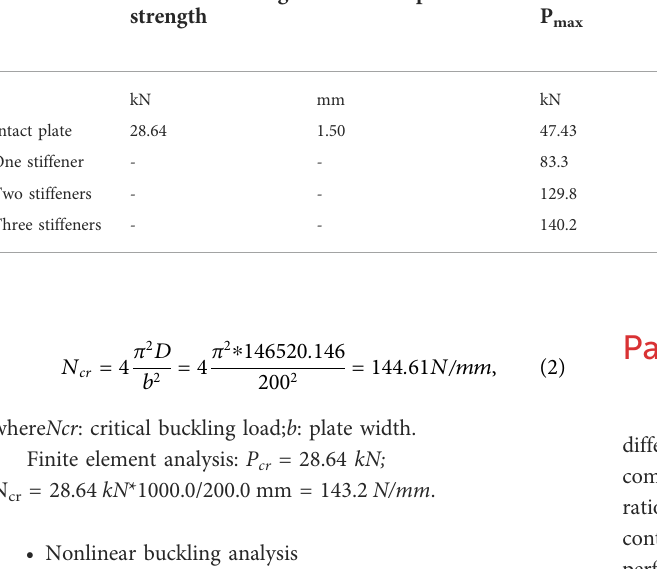
TABLE 1 Summary of analysis results for intact and stiffened plates. Plate form Critical buckling